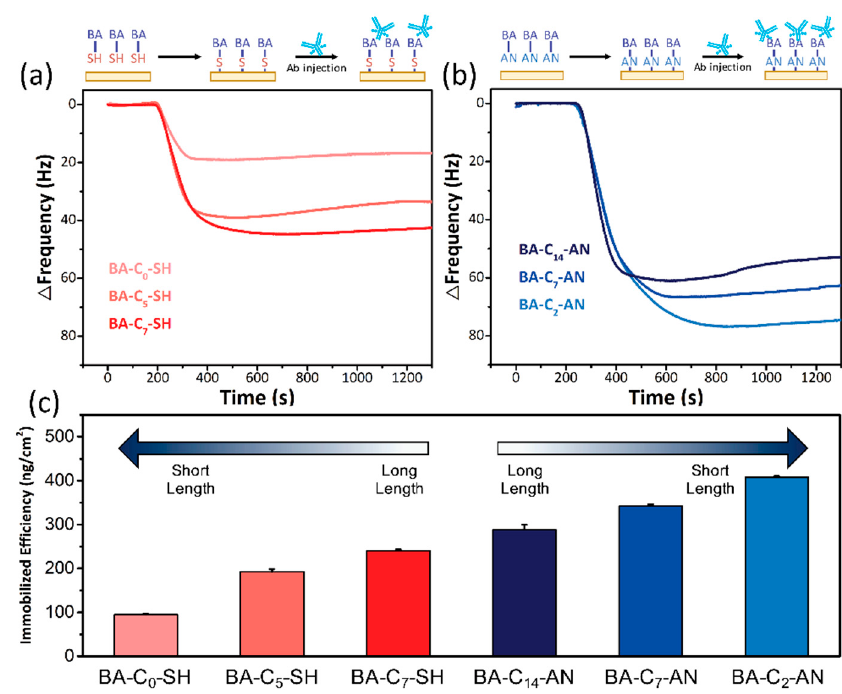
Figure 3. Recorded frequency responses to 25 µ g/mL Ab of ( a ) a thiol-based BA spacer (red lines) and ( b ) an aniline-based BA spacer (blue lines) modified by a QCM chip in a 1 × PBS buffer under real-time surveillance. ( c ) Comparison of the length-dependent effects on Ab-immobilization efficiency between the electrodeposition (blue) and SAM (red) methods. Table 2. Antibody capacity of a BA-modified QCM chip for the SAM and electrodeposition methods. Self-Assembled Monolayer Modification Method Electrodeposition Modified Modified